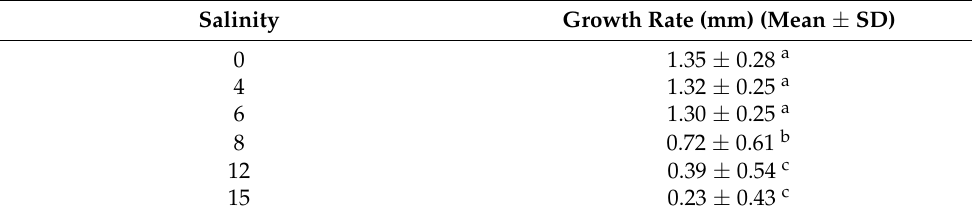
Table 3. Growth rate of M. macrocopa on different ranges of salinity. All values are mean ± standard deviation ( n = 3). The different small letters indicate a significant difference between different salinity levels ( p < 0.05).